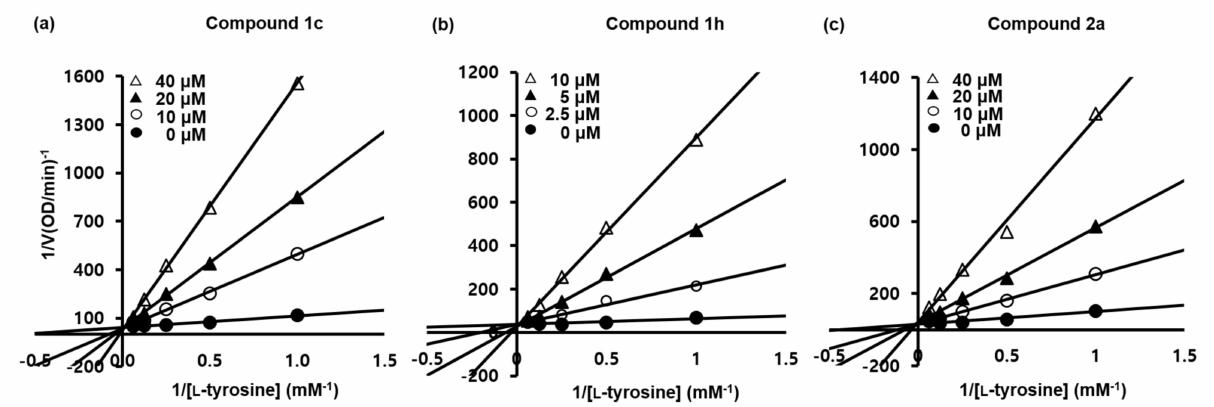
Figure 10. Lineweaver-Burk plots for the inhibition of mushroom tyrosinase activity by urolithin derivatives, ( a ) 1c and ( b ) 1h, and the ( c ) o -phenylbenzyl alcohol derivative 2a. Inhibition types of these three compounds were determined using Lineweaver-Burk plots. Data are indicated as mean values of 1/V, an inverse of the enhancement in absorbance at a wavelength of 475 nm per min of three independent experiments with four different concentrations of an L-tyrosine substrate. The concentrations of the test compounds used were 0 µ M (filled circles), 10 µ M (unfilled circles), 20 µ M (filled triangles), and 40 µ M (unfilled triangles) for 1c and 2a, and 0 µ M (filled circles), 2.5 µ M (unfilled circles), 5 µ M (filled triangles), and 10 µ M (unfilled triangles) for 1h. The modified Michaelis-Menten equation was utilized: 1/V max = (1/K M )(1 + [I]/K i ), where V max is maximum reaction rate, K M is the Michaelis-Menten constant, [S] is L-tyrosine concentration, and K i is an inhibition constant. All experiments were conducted independently in triplicate. Table 4. Kinetic analysis of compounds 1c, 1h, and 2a.